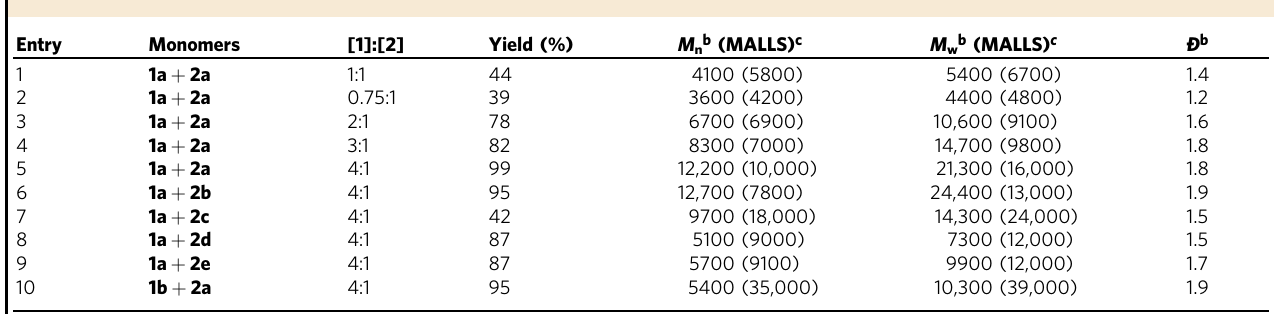
Table 1 Polymerization results of naphthols and internal diynes a .